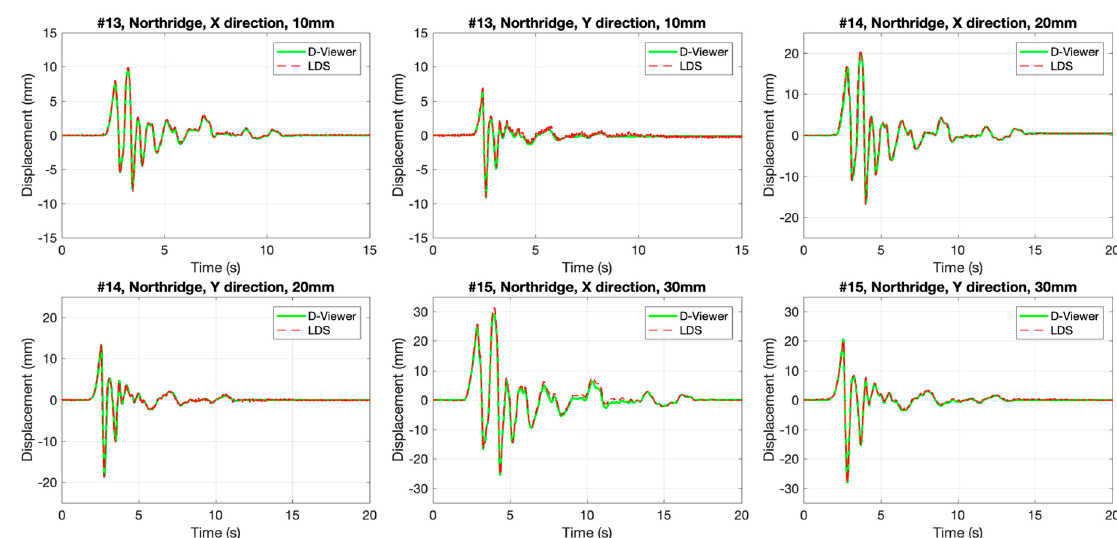
Figure A4. Experiment results of #13 to #15.